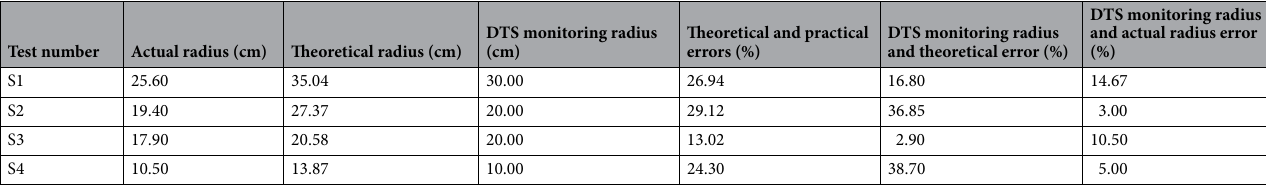
Table 4. Comparison of monitoring